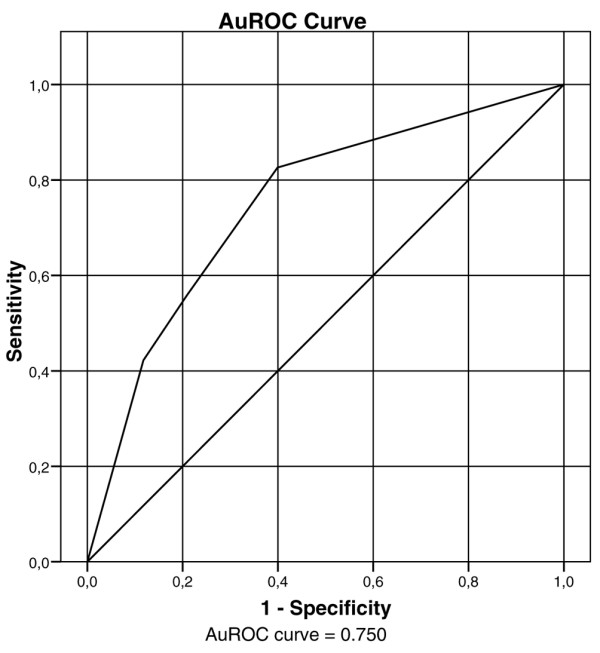
Area under the receiver operator characteristic (AuROC) curve for inhospital mortality for the Acute Kidney Injury Network criteria (P < 0.0001).